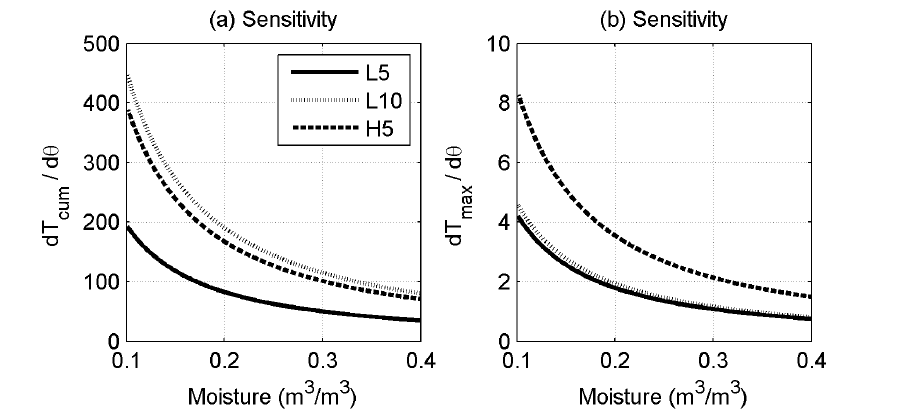
Figure 5. The sensitivity T cum ( a ) and the T max ( b ) to soil moisture when different heating strategies were used. The sensitivity curves are derived from the fitted T cum and the T max to soil moisture relationship in Figure